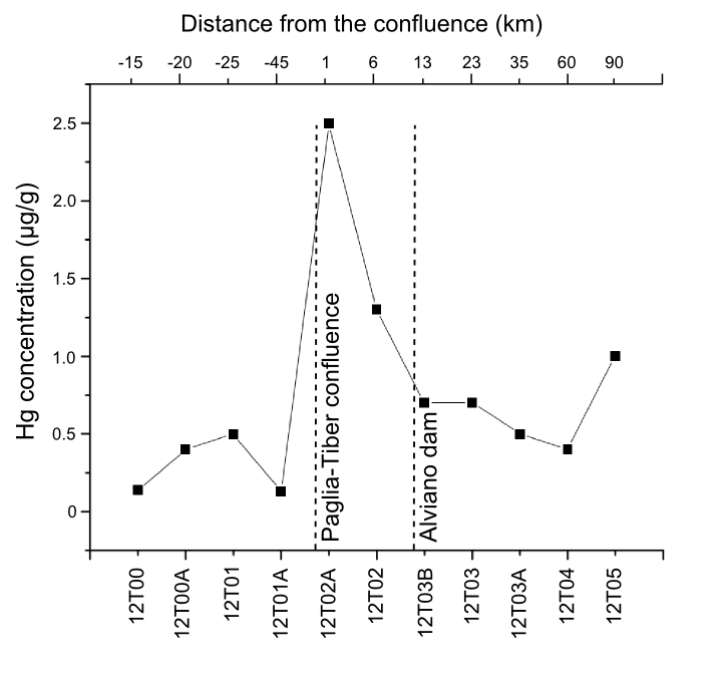
Figure 7. Total mercury concentrations in the Tiber River stream sediment samples collected in the 2012 campaign. Dashed lines represent the confluence point with the Paglia River and Alviano